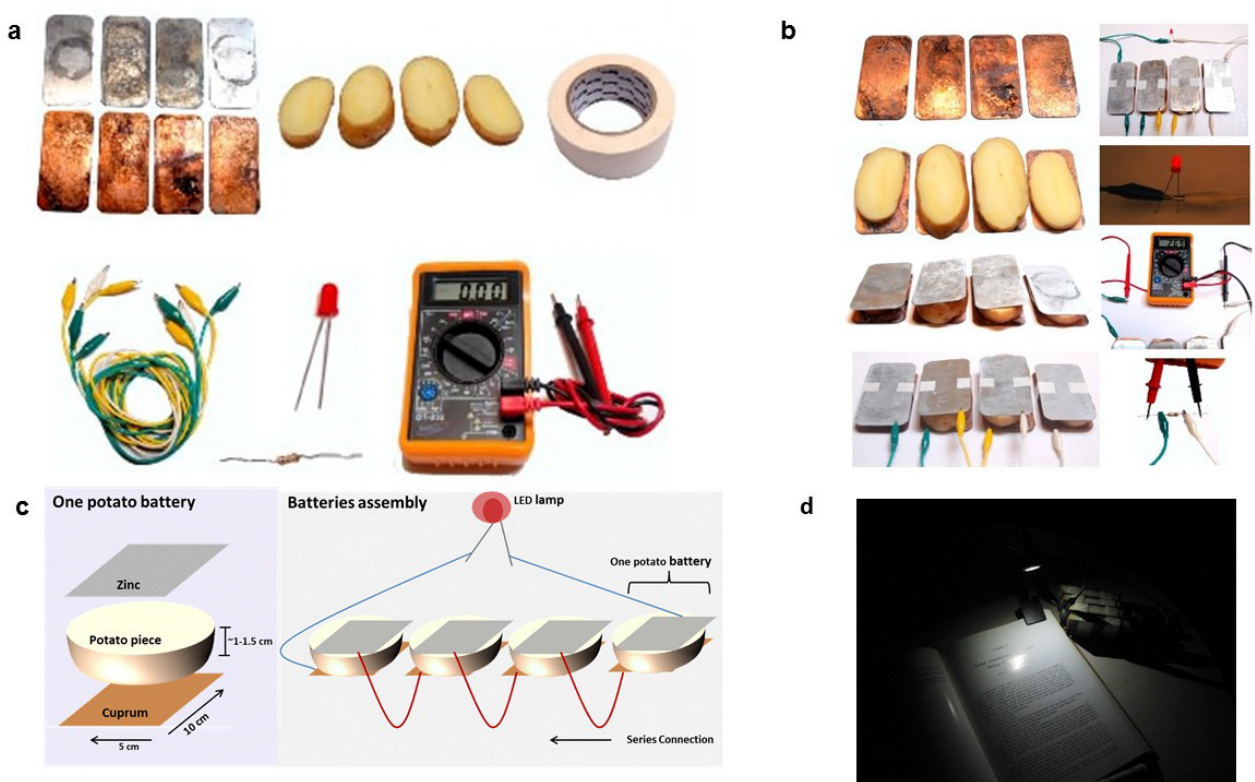
Figure 2. “Make yourself a battery” toolkit. ( a ) Basic components required to assemble a battery at home. Zinc and Copper plates (~5×10cm), wires, boiled potato, sealing tape, light emitting diode (LED). Test resistor and voltmeter are used for performance measurements. ( b ) Process for a single cell and complete battery assembly. Assembly description of four potato batteries to turn on one LED lamp ( i ) put 4 plates on a rigid substrate; ( ii ) add 4 boiled slices of potato, once cooled, on the metal plates, recommended to cover the metal plates with the potatoes, as much as possible; ( iii ) cover the potatoes with the Zn plates; ( iv ) seal the cells with a tape and connect the batteries with the cables - each metal should be connected to the closest battery to the second metal except to metal plates on the edges; ( v ) connect the not connected plates, to the LED lamp, the electric circle is closed; ( vi ) in a case everything connected right, the LED lamp will be turned on; ( vii ) to measure open circuit voltage, a voltmeter should be connected instead the lamp; ( viii ) to measure the current in the system, connect the 100ohm resistor instead of the LED and measure the voltage on it. ( c ) Schematic representation of a complete lighting device, powered by Zn/Cu/boiled potato battery. ( d ) Lighting device performance example for book page illumination in a completely dark